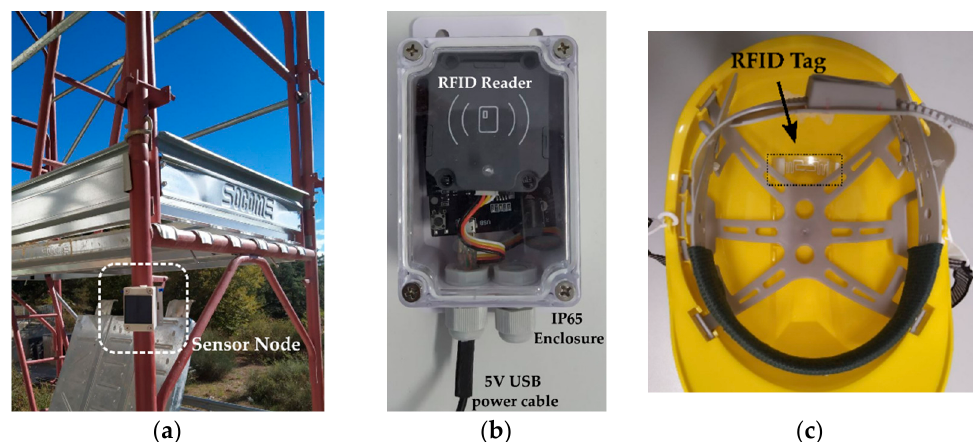
Figure 3. ( a ) A structural node mounted on the side of a scaffolding installation and ( b ) on an entrance gate. ( c ) An RFID tag inside a worker’s helmet.